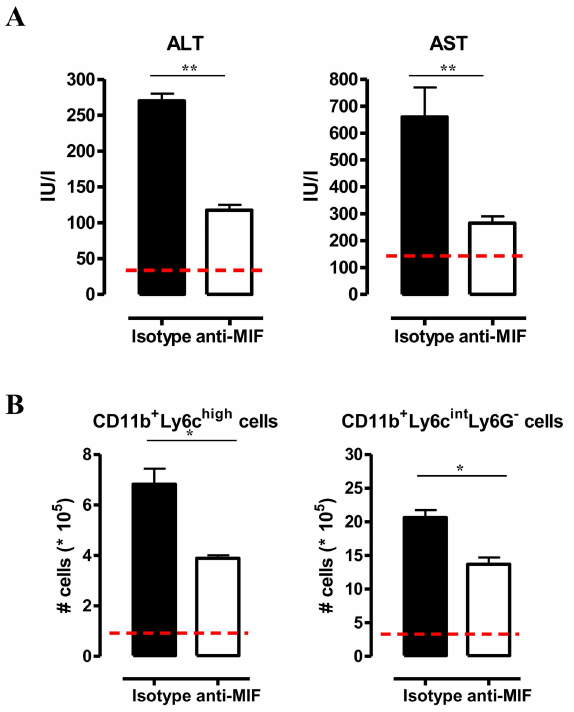
Figure 4. Anti-MIF treatment reduces serum ALT/AST levels and affects liver cell composition during T.brucei infection. (A) Serum ALT and AST levels of non-infected (dashed line), isotype control antibody treated (black box) and anti-MIF IgG treated (white box) WT C57Bl/6 mice at day 25 p.i. (B) Total numbers of liver CD11b + Ly6C high - Ly6G 2 and CD11b + Ly6C int Ly6G + cells in the chronic (day 25 p.i.) phase of infection calculated using the gating strategy described in Fig. 3B. Results are representative of 2 independent experiments and presented as mean of 3 individual mice 6 SEM (*: p-values # 0.05, **: p-values # 0.01).